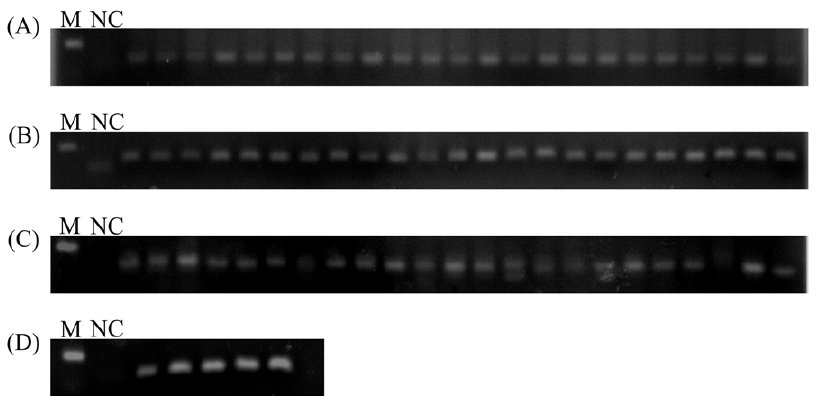
Figure 3. Stem-loop RT-PCR analysis of novel miRNAs expression with 30 cycles. (A) line 2–24 indicated novel miRNA from novel01 to Novel24; (B) line 2–24 indicated novel miRNA from novel25 to Novel50; (C) line 2–24 indicated novel miRNA from novel51 to Novel74; (D) line 2–6 indicated Novel75, Csi-miR156, Csi-miR172, miR396 and PtmiR93; NC indicated negative control; M indicated 100 bp.